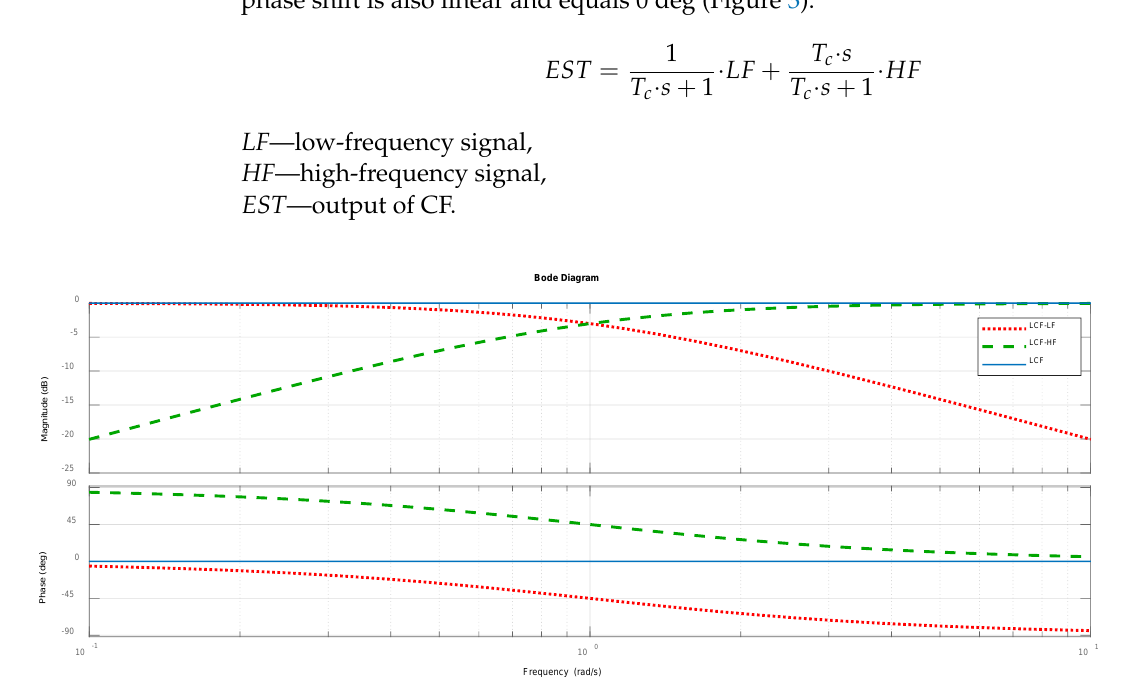
The complementary filter transfer function is represented by Equation (14). The amplitude of linear CF is unity (0 dB magnitude) over the complete frequency range. The phase shift is also linear and equals 0 deg (Figure 3). Figure 2. Complementary filter diagram.